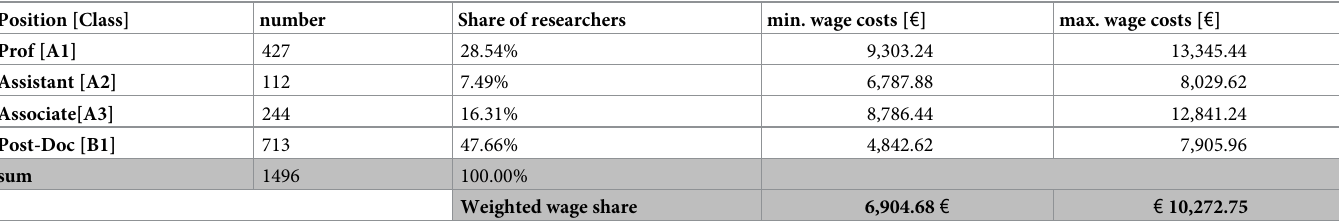
Table 4. Wage costs of social